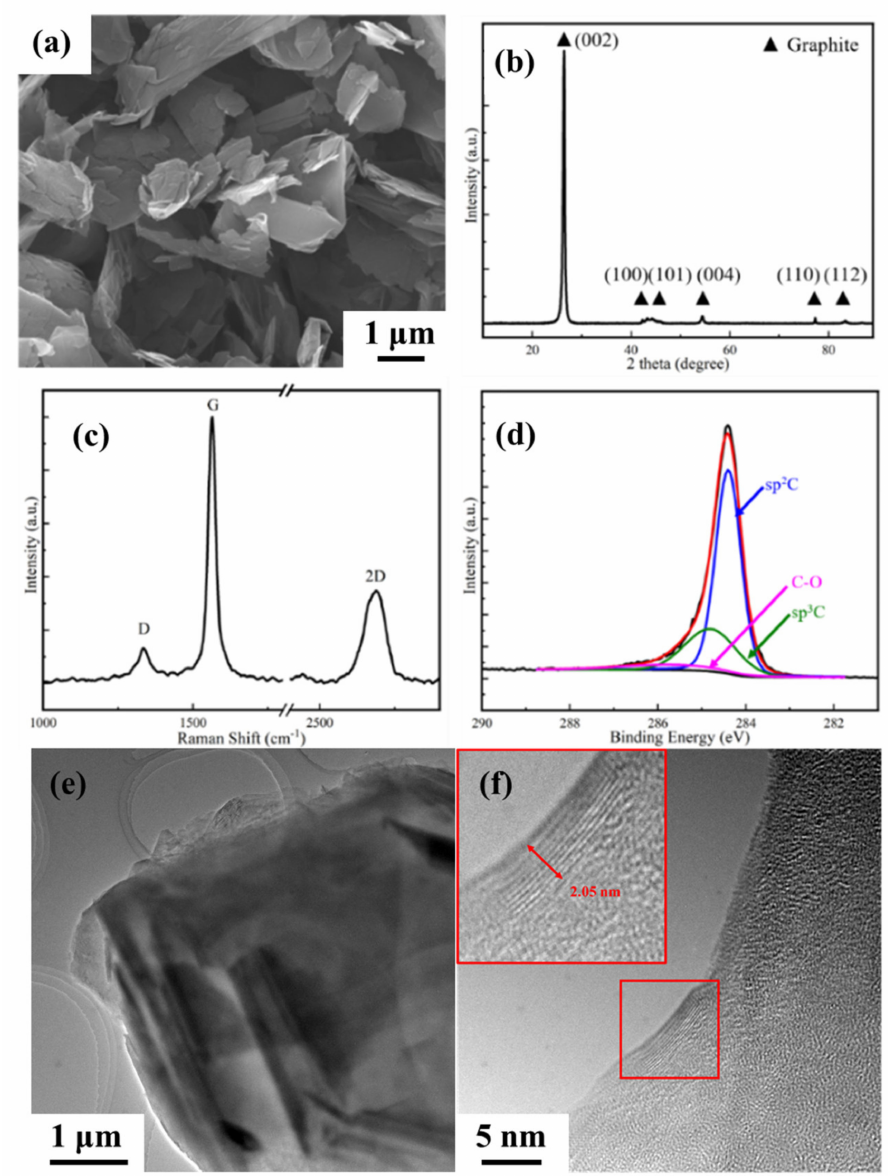
Figure 2. Surface morphology and microstructure characterization of original graphene. ( a ) SEM characterization of graphene, ( b ) XRD characterization result of graphene, ( c ) Raman spectrum char- acterization of graphene; ( d ) XPS characterization of graphene; ( e ) Bright field image characterization of graphene; ( f ) HRTEM characterization of